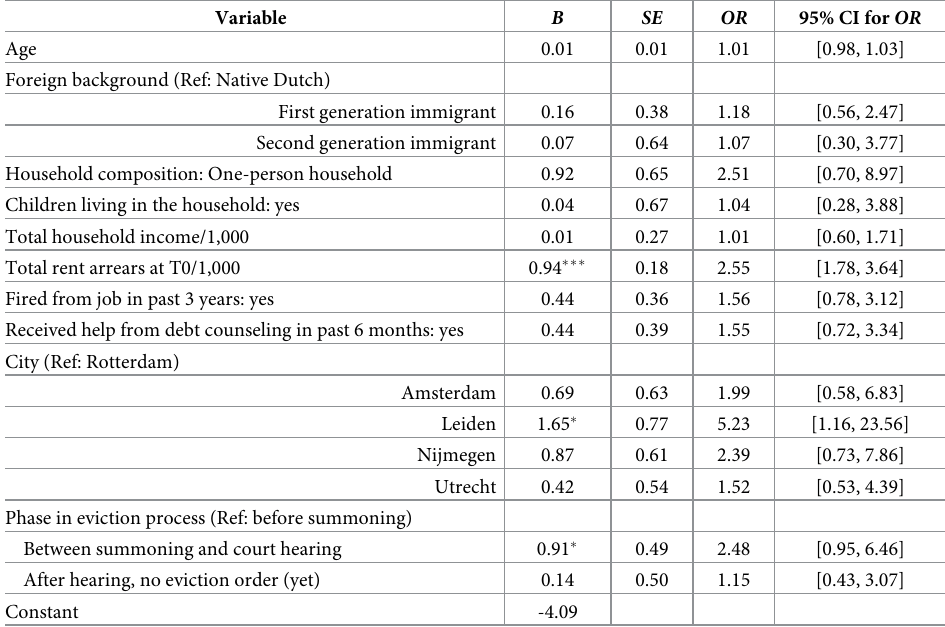
Phase in eviction process (Ref: before summoning) Between summoning and court hearing